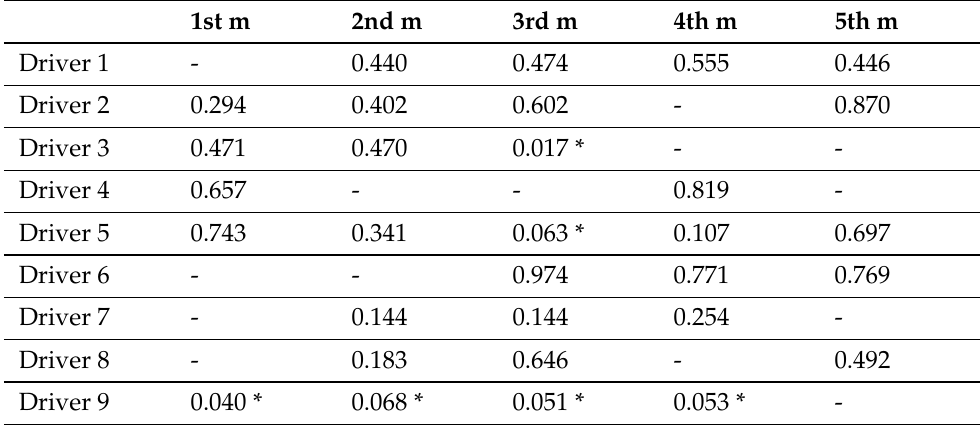
Table 2. Average p -value for speech signal with regard to time (minute) for Experiment 1 ( p -value below the threshold of 0.10 is marked using *).